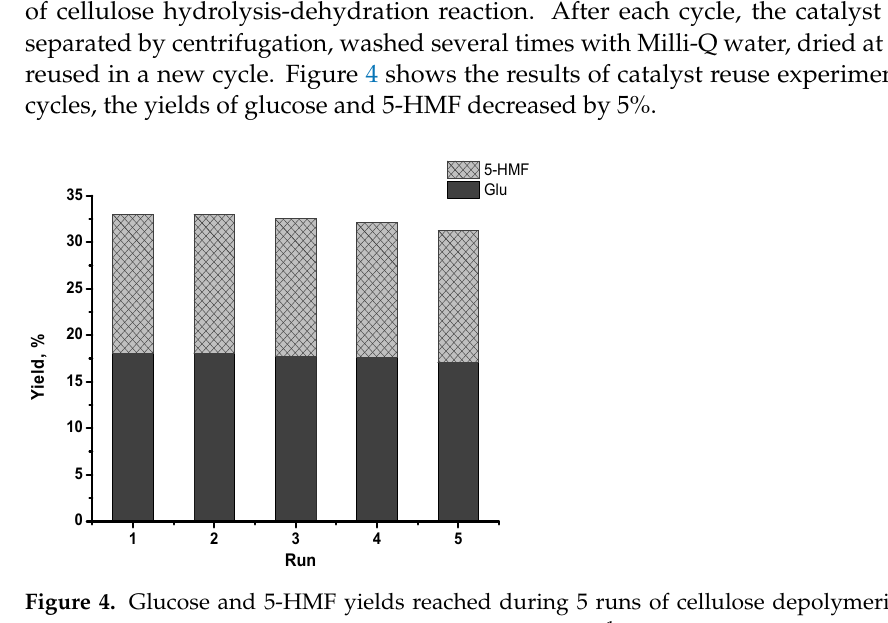
Figure 4. Glucose and 5-HMF yields reached during 5 runs of cellulose depolymerization over ZrO 2 -W-7 catalyst. Reaction conditions: [Cell] = 10 g·L − 1 , [Cell]:[Cat] = 1:20, 453 K, P Ar 1 MPa, 1000 rpt, reaction time 7